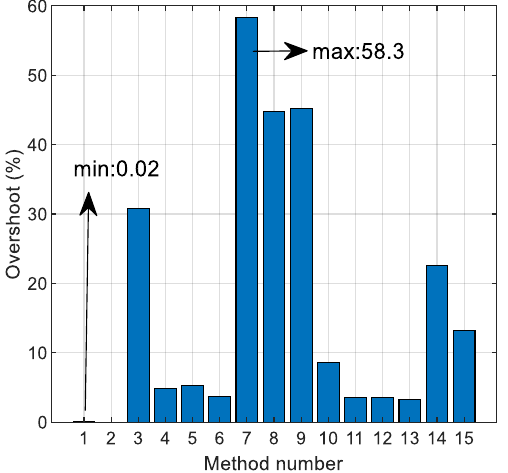
Figure 8. Overshoot for each method from Table 3.